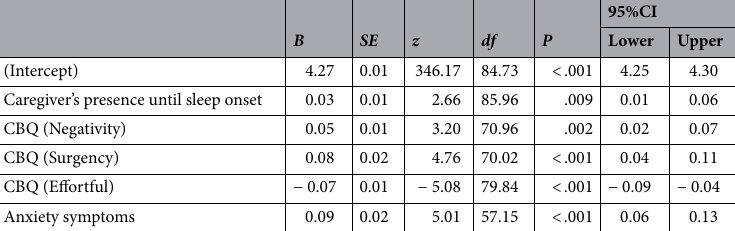
Table 3. Results of the minimum BIC Poisson regression model for sleep problems. The model was estimated using multiple imputation (see "Methods" section).